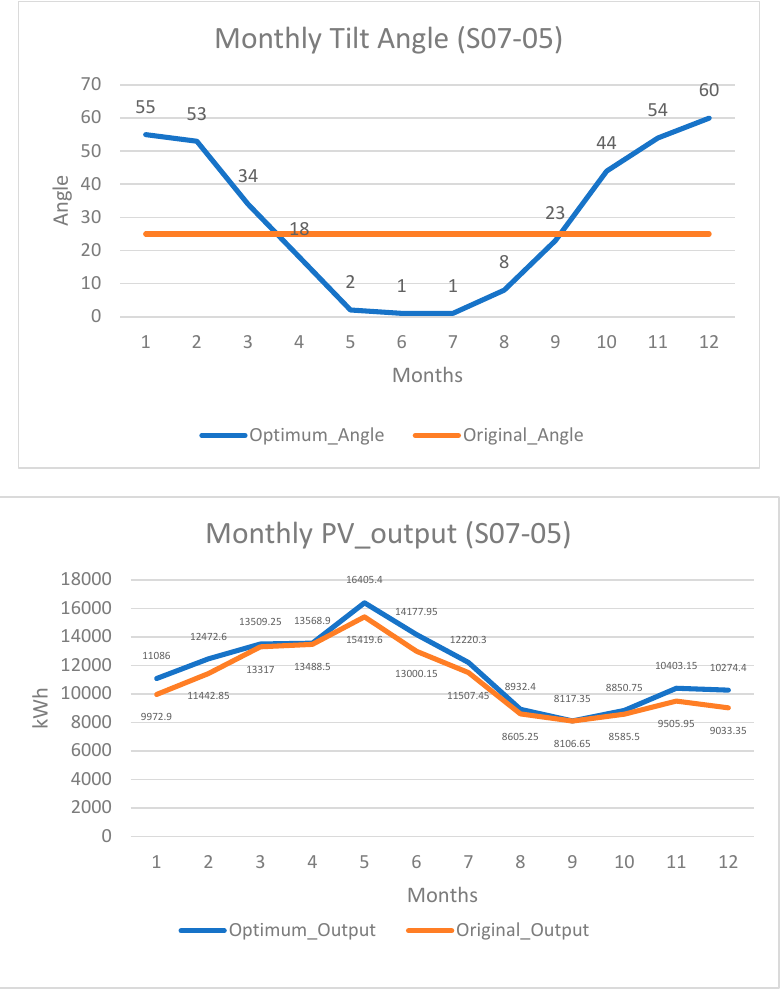
Figure A2. Monthly tilt angles and outputs of S07-05 module.